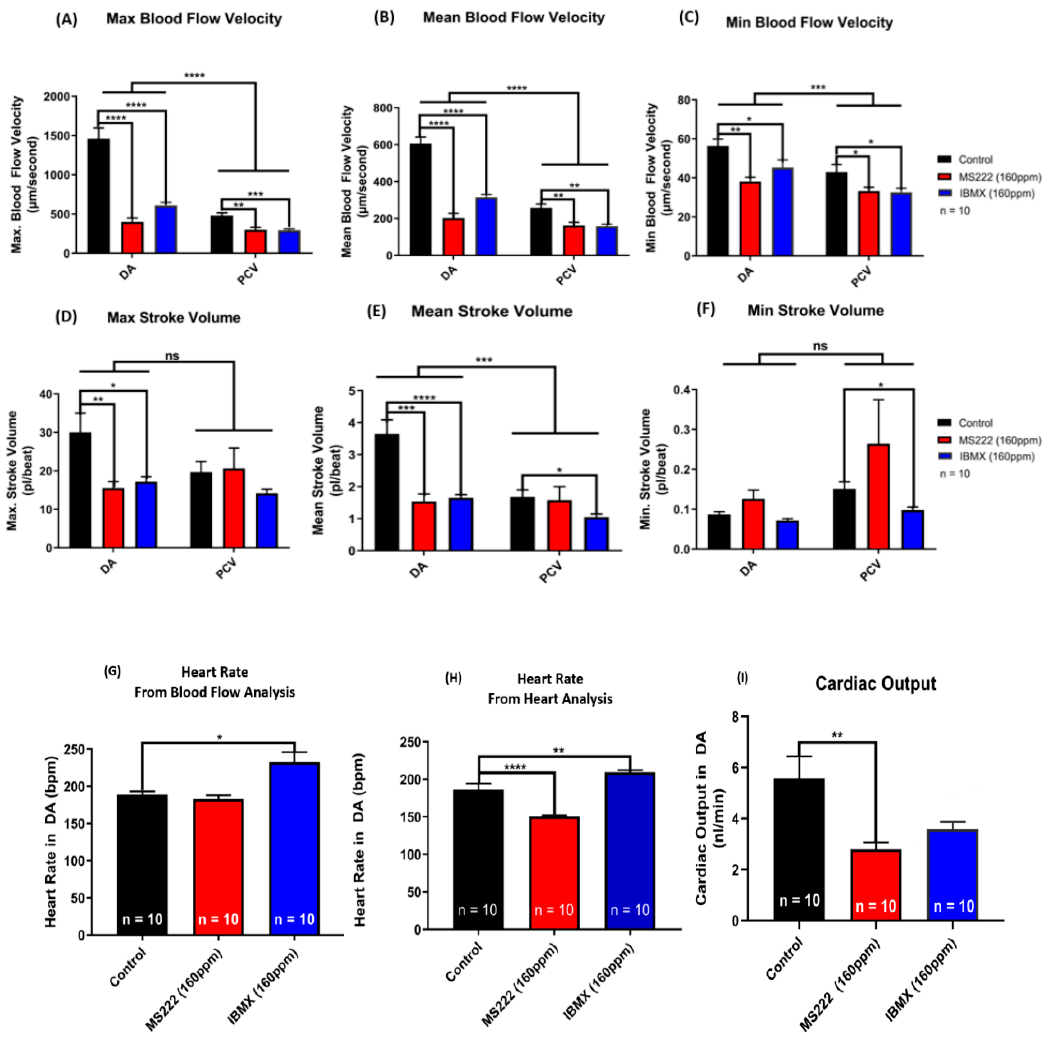
Figure 5. Functional assessment of cardiovascular performance in zebrafish embryos after treatment with MS222 and IBMX based on images captured from the artery or vein. MS222 and IBMX were applied to zebrafish embryos at 72 hpf at 160 ppm and the cardiovascular performance was recorded and analyzed by the ImageJ-based method established in this study. ( A – C ) Maximum, mean, and minimum blood flow velocity in dorsal aorta (DA) and posterior cardinal vein (PCV), ( D – F ) Maximum, mean, and minimum stroke volume in the DA and PCV, ( G ) Heart rate in the DA calculated from blood flow, ( H ) Heart rate calculated directly from heart, and ( I ) Cardiac Output of the DA. Data are expressed as mean ± SEM values and were analyzed by two-way ANOVA in ( A – F ) and one-way ANOVA in ( G – I ) ( n = 10 for each chemical treatment; * p ≤ 0.05, ** p ≤ 0.01, *** p ≤ 0.001 and **** p ≤ 0.0001, ns =